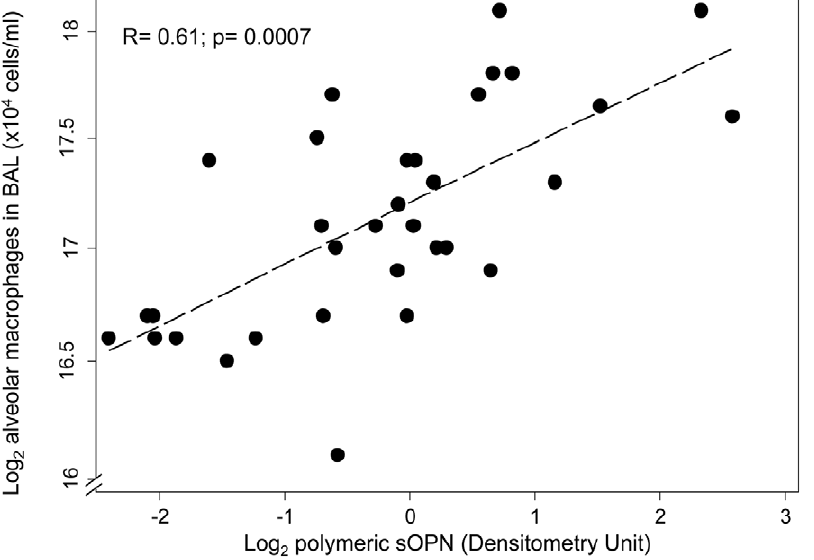
Figure 5. Alveolar macrophages and sOPN. Correlation between alveolar macrophage concentration (log base 2) and polymeric sOPN optical density (log base 2) in BAL (R=0.61; p=0.0007).